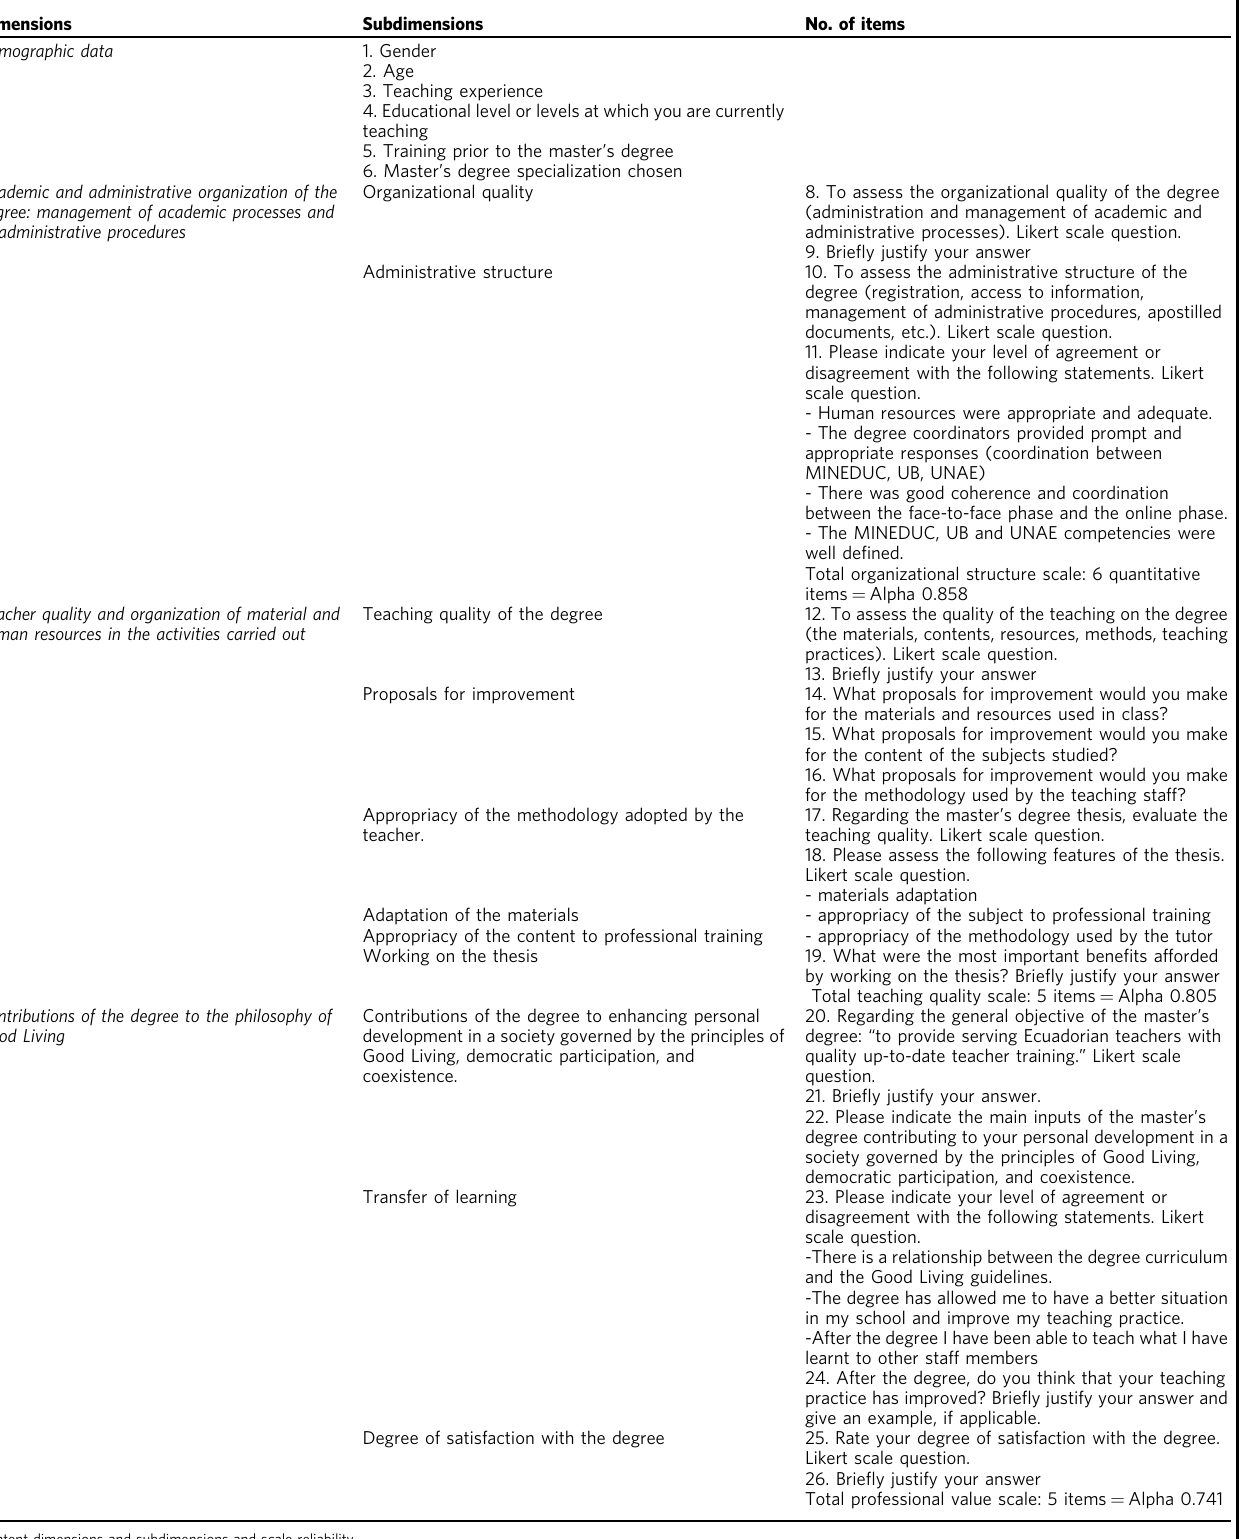
Table 1 Table of survey speci fi